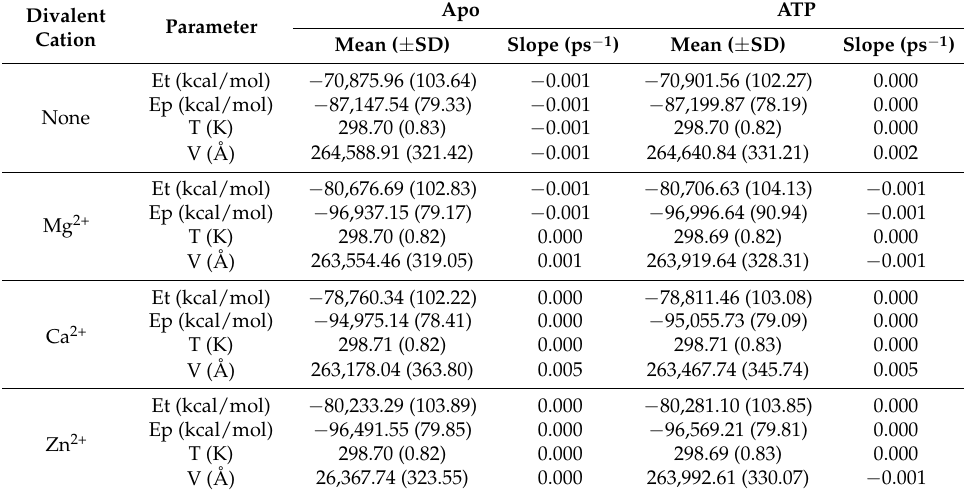
Table 5. The simulation quality analysis of KpNNAT-apo and KpNNAT-ATP complex in the absence and presence of divalent cations. This table shows the mean, standard deviation (SD), and slopes of total energy (Et), Potential energy (Ep), temperature (T), and volume (V) of the systems over 100 ns simulation